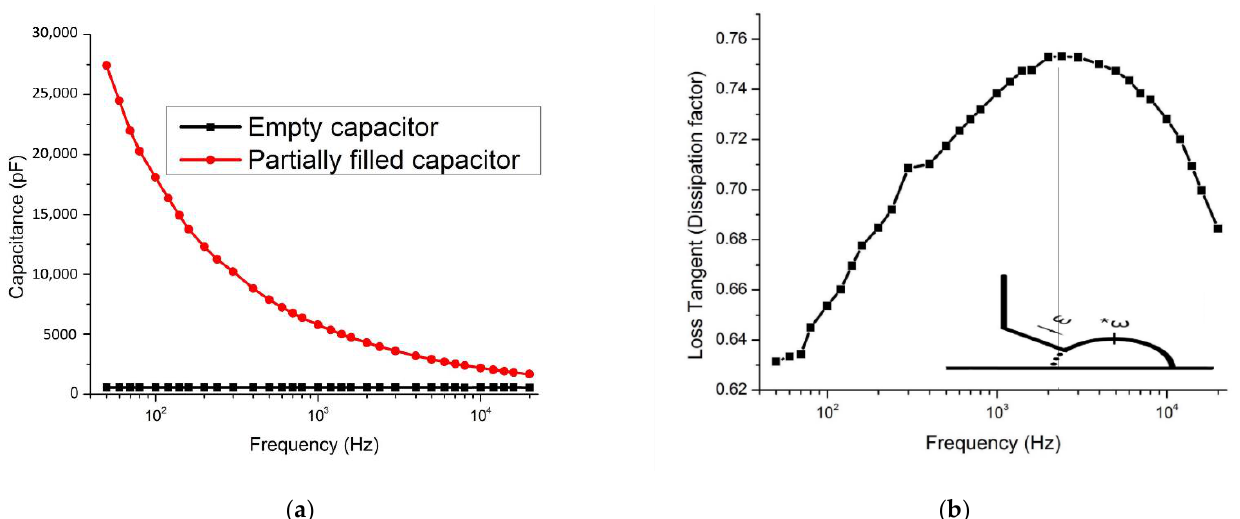
Figure 8. ( a ). The capacitance of the empty capacitor and capacitor with the inserted sample. ( b ). A peak of loss tangent indicates the ionic relaxation. An ideal Nyquist curve was inserted to make a comparison. The frequency ω increases following the arrow direction. ω * indicates the frequency at highest point of the